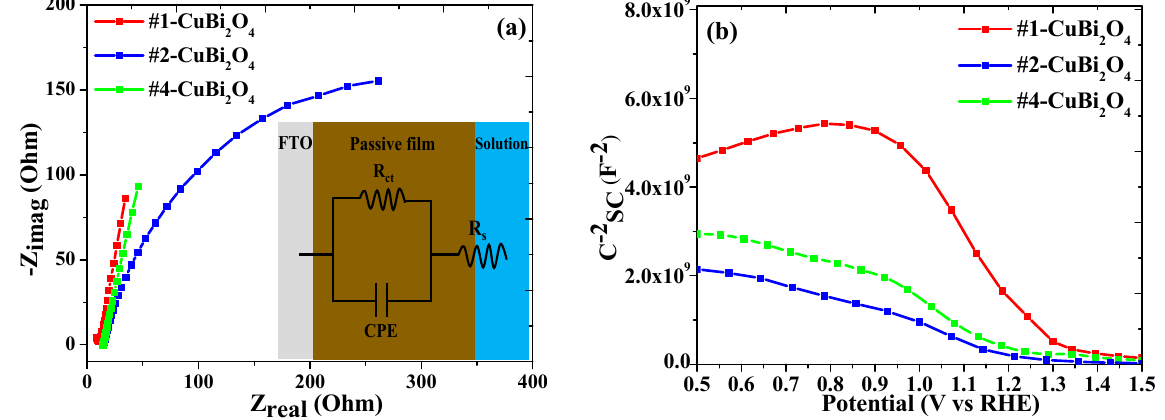
Figure 5. ( a ) Nyquist and ( b ) Mott–Schottky plots of the #1–CuBi 2 O 4, #2–CuBi 2 O 4 , and #4–CuBi 2 O 4 photocathodes. Under 100 mW/cm 2 illumination, the electrolyte was a 0.5 M aqueous solution of Na 2 SO 4 .